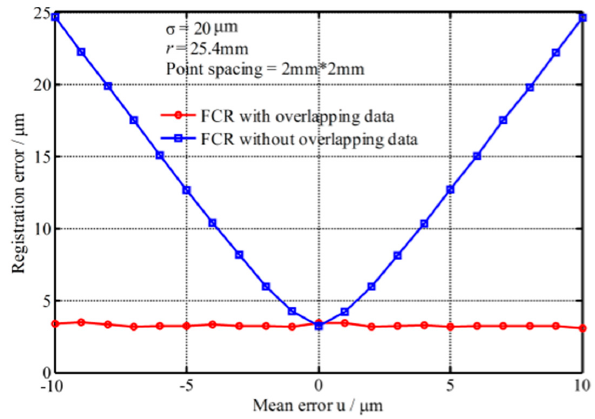
Figure 8. Registration errors changed with the mean